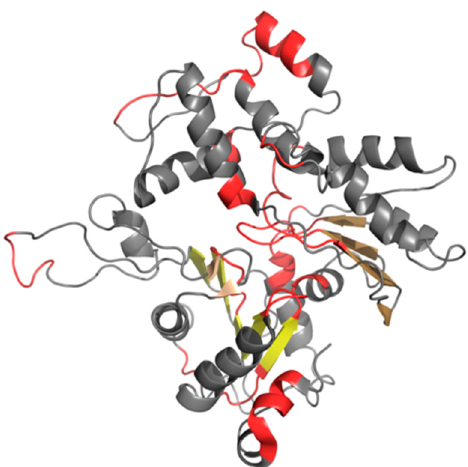
Figure 10. 3D presentation of F chain from F-actin (PDB ID 3J8I). Beta sheets are displayed in different shades of yellow. Red fragments distinguish residues that cause discordance between T and O distributions. These fragments correspond to highlighted parts of hydrophobicity profiles presented in Figure 9.